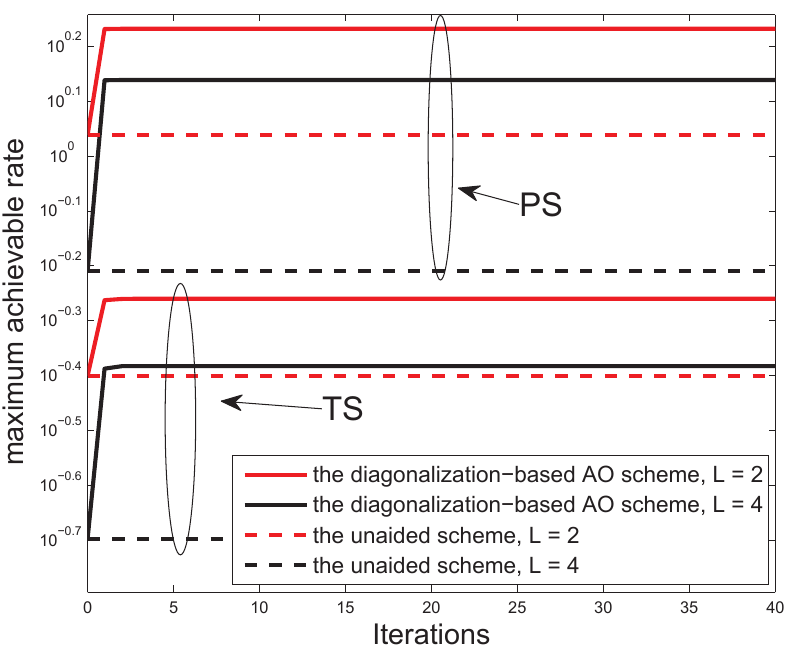
Figure 4. The MAR performance versus the number of iterations for N = 2 and L ∈ { 2,4 } .